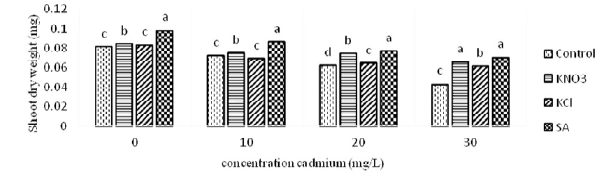
Fig. 4. Root length of unprimed (UPS) and primed (PS) fenugreek seedlings ( Trigonella foenum-graecum L.) under different Cd concentrations Root length was measured in unprimed seeds and when seeds were primed by 100 mg/L SA and -1 MPa KNO 3 and KCl solution for 24 hours. The unprimed seeds were used as the control. Means with similar letters were not significantly different (p ≤ 0.05) based on LSD test.